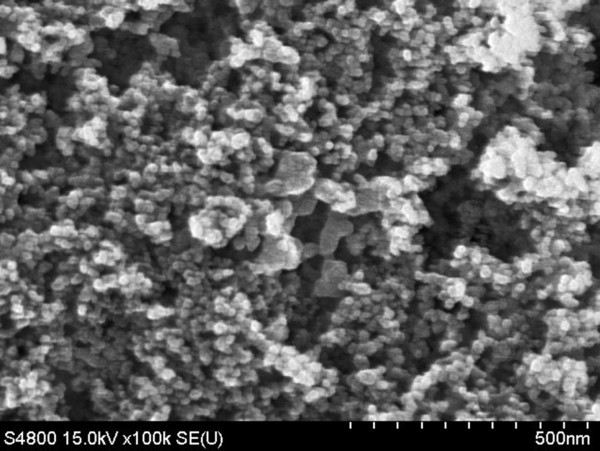
FE-SEM images of Al2O3 nanoparticles.